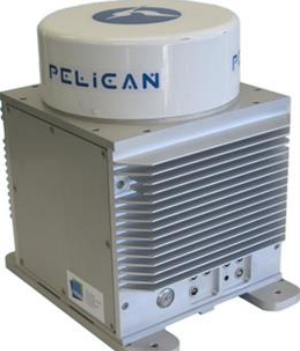
Figure 2. General view of PELICAN radar. The size and weight of PELICAN radar facilitate its implementation on various kinds of